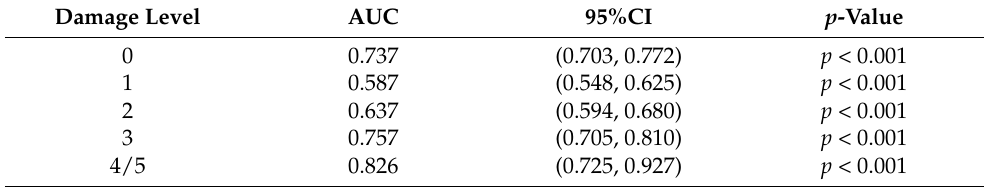
Table 8. Area under ROC